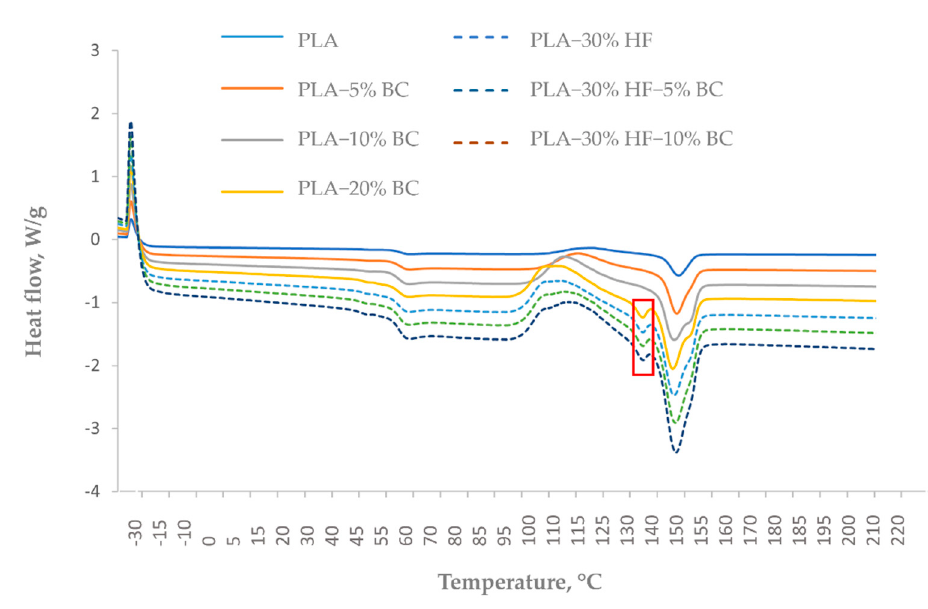
Figure 4. DSC thermogram from the second heating cycle of the PLA-based composites. Table 6. DSC analysis results of PLA-based composites.